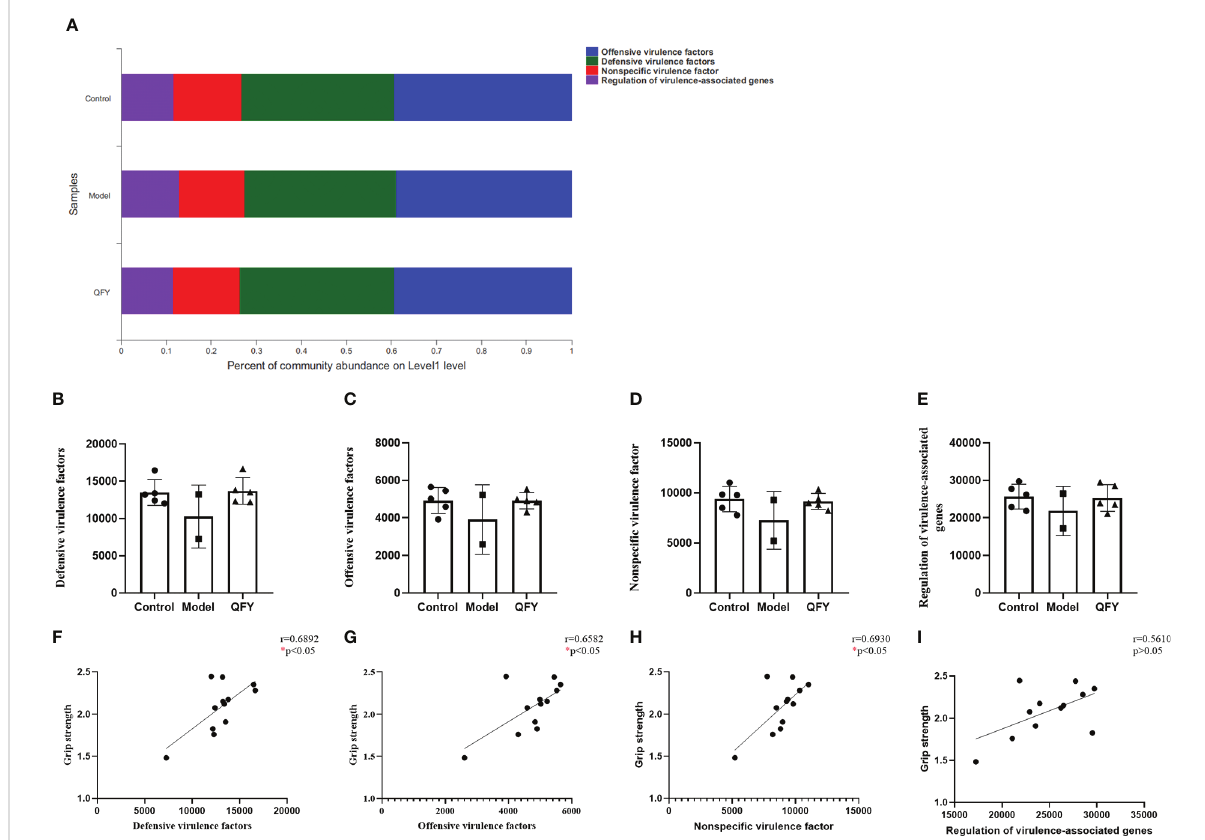
FIGURE 10 The effect of Qi-Fu-Yin on the function of virulence factor of intestinal microorganisms in APP/PS1 transgenic mice. (A) Percent of community abundance on virulence factor level 1 (B) Defensive virulence factors, (C) Offensive virulence factors, (D) Nonspeci fi c virulence factor, (E) Regulation of virulence-associated genes, (F) The correlation between grip strength and abundance of defensive virulence factors, (G) The correlation between grip strength and abundance of offensive virulence factors, (H) The correlation between grip strength and abundance of nonspeci fi c virulence factor, (I) The correlation between grip strength and abundance of regulation of virulence-associated genes. Mean ± SD, n=2~5, * P < 0.05, unpaired Student ’ s- t test. GraphPad Prism 8.0.1